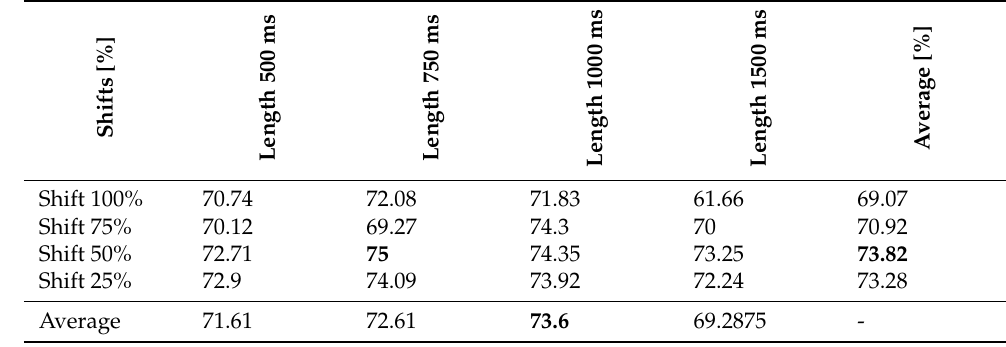
Figure 10. Accuracies for maximal frequency limits with the minimal frequency set to 0 Hz ( a ), and a minimal frequency test with the maximal frequency set to 8 kHz ( b ) using 1 s-long spectrograms. The tests clearly show that both maximal upper and lower frequency limits are needed to secure the best recognition scores. 5.2.3. Speech Recognition The results for 0, 150, and 300 Hz minimal frequencies combined with 4 and 8 kHz maximal frequencies are depicted in Figure 11 in the case of magnitude spectrograms.